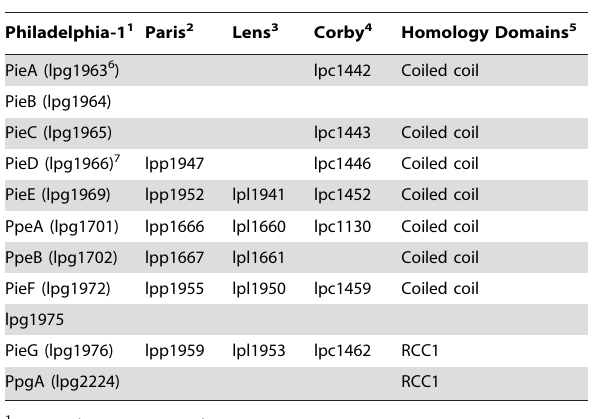
Table 1. Pie protein families and their homologues.